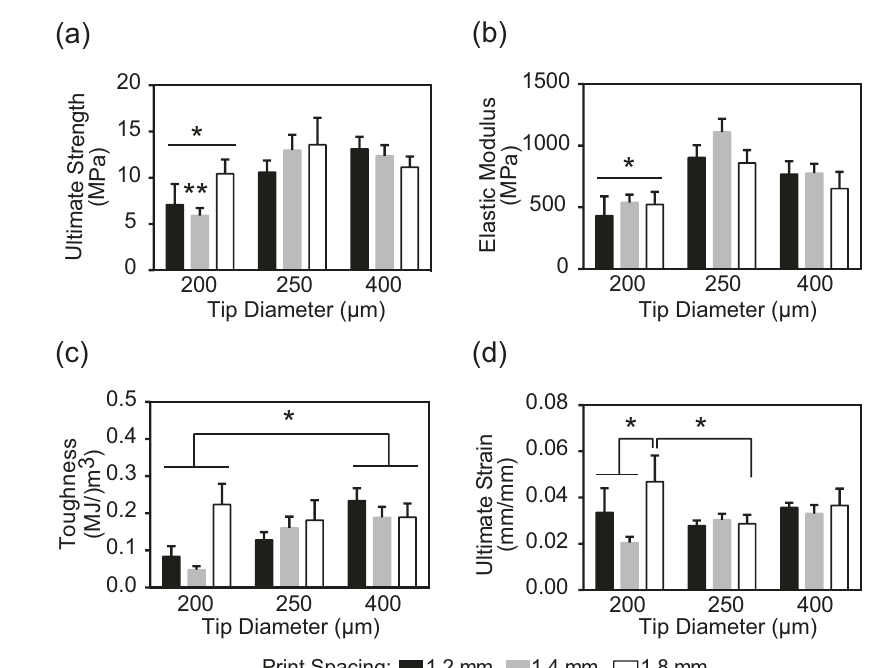
Fig. 8 Mechanical properties of the 3D-printed cylindrical scaffolds using various tip diameters and print spacing. a The ultimate strength of the scaffolds printed with 200 µm TipD had signi fi cantly (* p < 0.05) lower ultimate strength compared to the results obtained from the other two groups tested; the 1.4 mm PrSp exhibited the lowest strength (* p < 0.05) compared to the other two PrSps tested in the present study. b The elastic moduli of the scaffolds printed with the 200 µm TipD were signi fi cantly (* p < 0.05) lower than those printed with 250 and 400 µm